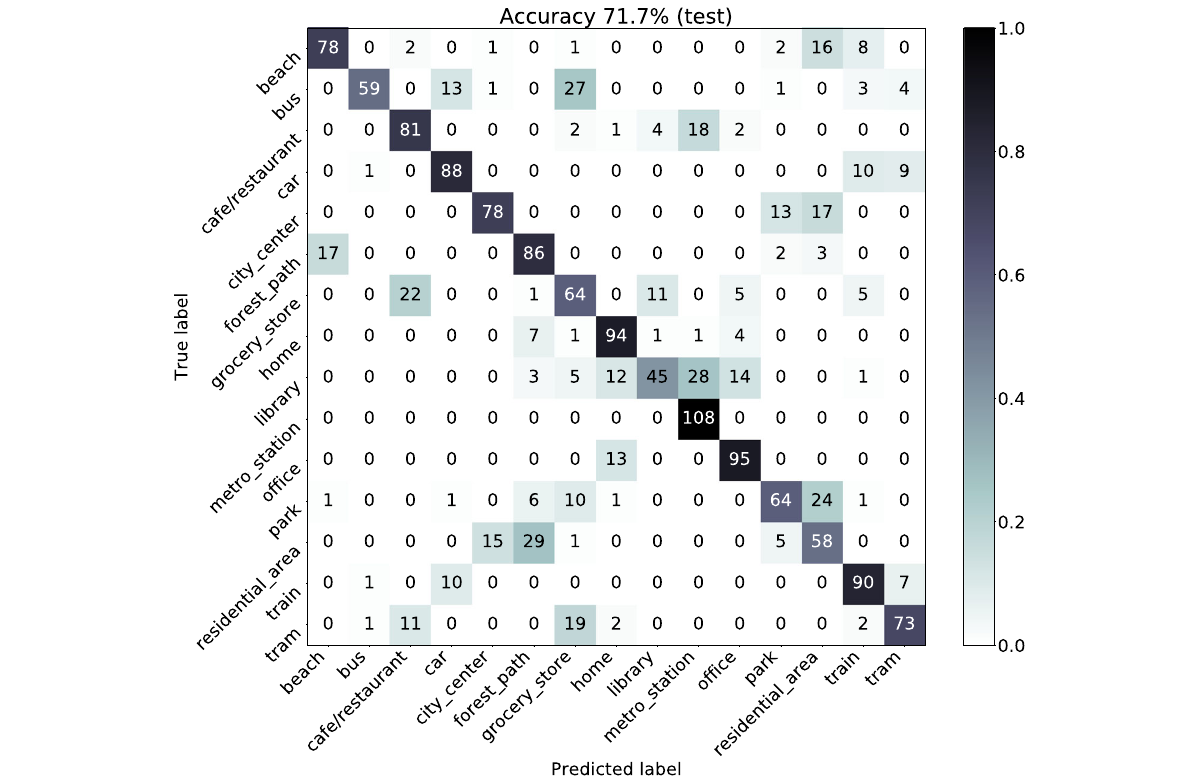
Fig. 3 The confusion matrix (CM) of the best prediction on the test set of the DCASE 2017, task 1 database. Confusion is high for the acoustic scene “residential area” which is often mistaken for “city” or